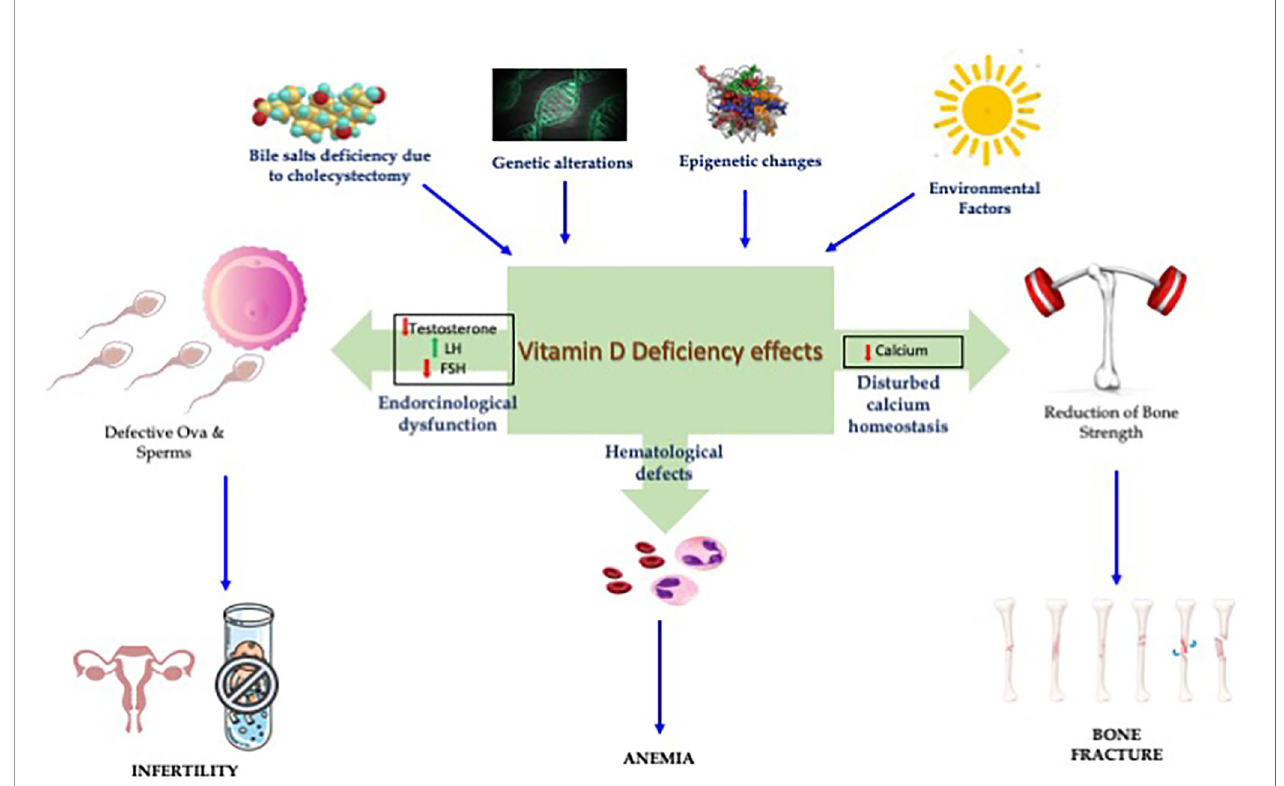
FIGURE 1 | Impact of vitamin D in reproduction and bone